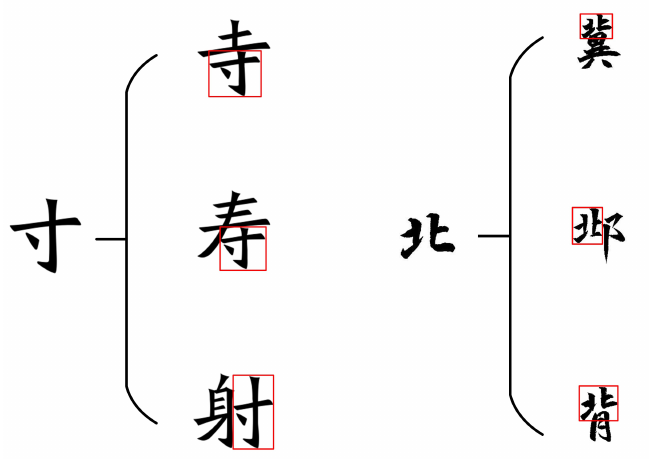
Figure 1. One component can be deformed to form different Chinese characters.